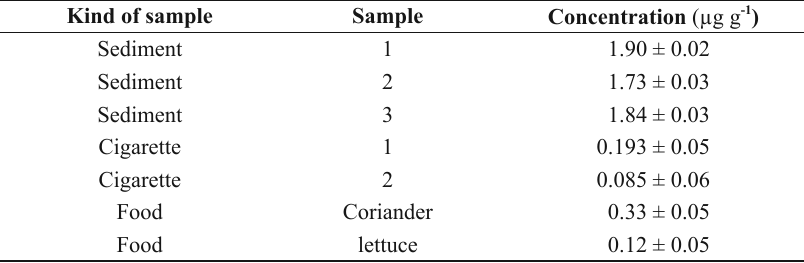
Determination (N=3) of cadmium in samples of sediments, cigarettes and